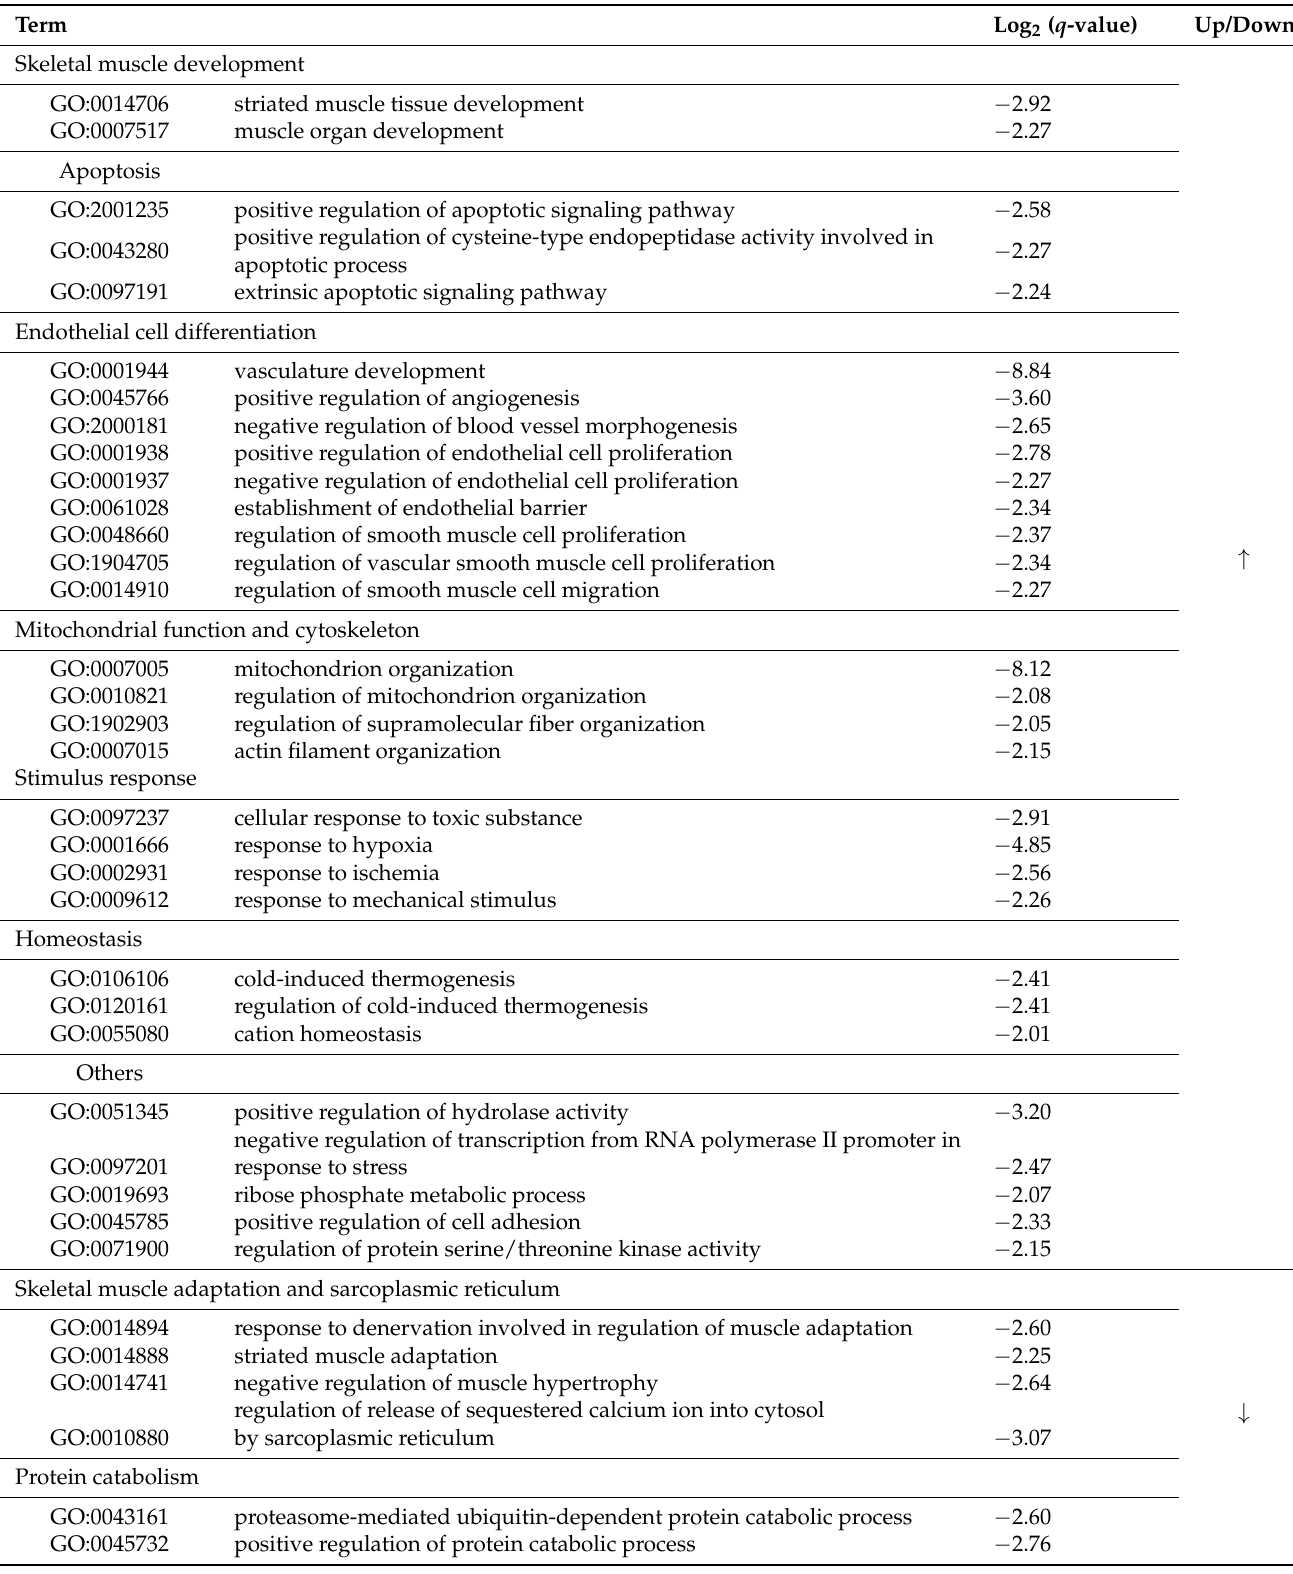
Table 3. Highlighted functional annotation within gene ontology (GO) terms (Transcriptome results). Up/Down arrows show an upregulating trend/downregulating trend after categorizing genes those have increased fold changes of >1.5 or decreased fold changes of <1.5 into GO function enrichment analyses. Comparison was carried out using Low protein vs. Control diet